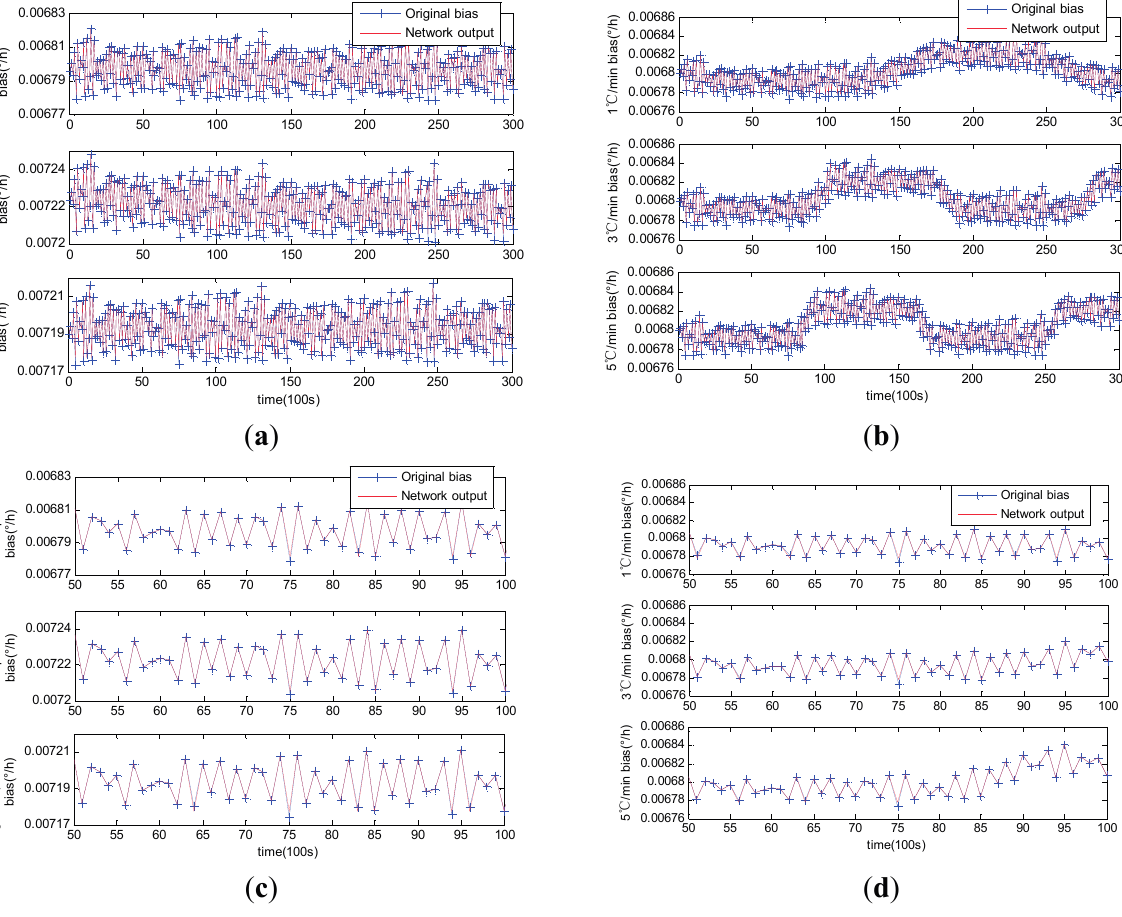
Figure 8. Identification curves using modified RBFNN: ( a ) constant temperature; ( b ) variable temperature; ( c ) enlarged (a) in the horizontal axis from 50 to 100; ( d ) enlarged (b) in the horizontal axis from 50 to 100.